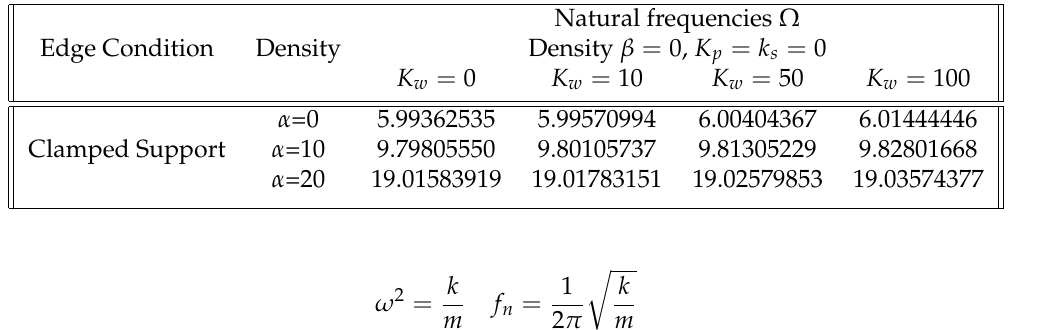
Table 5. Influence of Winkler foundation coefficient on natural frequency